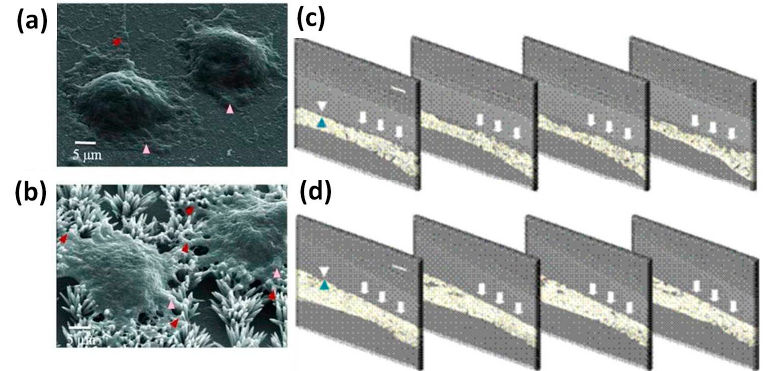
Figure 4. Panels ( a , b ): Scanning electron microscopic images of MC3T3-E1 osteoblasts grown on ( a ) ZnO film and ( b ) ZnO nanoflowers after cultivation for a day. Lamellipodia and filopodia were indicated with pink and red arrowheads, respectively. Panels ( c , d ): sequential synchrotron X-ray tomographic images of regenerated bones to ( c ) ZnO film and ( d ) ZnO nanoflowers on ZnO film-coated silicon substrate implanted in the calvarial bone defects of rats for four weeks. Arrows ( ▲ or ▼ ) indicate the interface between ZnO surface and the regenerated bone exhibiting the topographic effect of ZnO nanoflowers on osseointegration. Scale bars correspond to 100 μ m. Modified with permission from reference [15]. Copyright (2010) John Wiley & Sons, Inc.